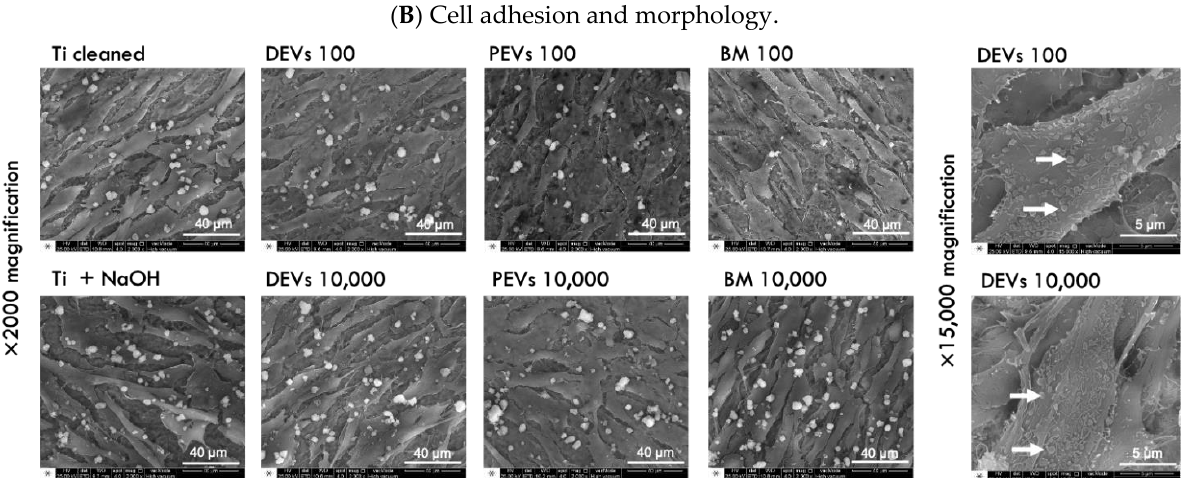
Figure 5. Proliferation and morphology of cells on SurfEV. ( A ) Osteoblast proliferation (% control), CCK-8, n = 8. Points are means of two independent experiments carried out in quadruplicate, and error bars represent confidence intervals ( α = 0.05). ( B ) Osteoblast adhesion and morphology seeded on Ti surfaces coated with different EVs and the control groups (Ti cleaned and Ti treated with NaOH). SEM (×2000 and ×15,000 magnification). White arrows indicate the presence of membrane exfoliated structures on osteoblast cytoplasm.